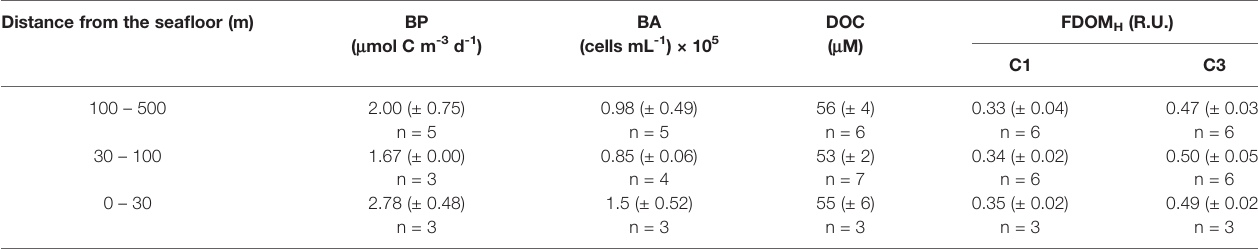
TABLE 1 | Mean (± 1 standard deviation) of bacterial production (BP), bacterial abundance (BA), and concentrations of dissolved organic carbon (DOC) and C1 component (C1) and C3 component (C3) of humic-like DOM (FDOM H ) in the water column at a designated depth range from the sea fl oor. Distance from the sea fl oor